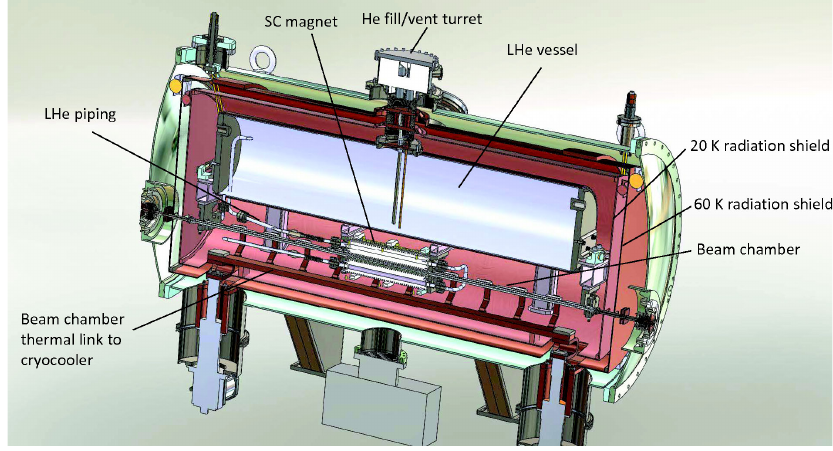
FIG. 5. Solid model cutaway view of the inside of the SCU0 cryostat.